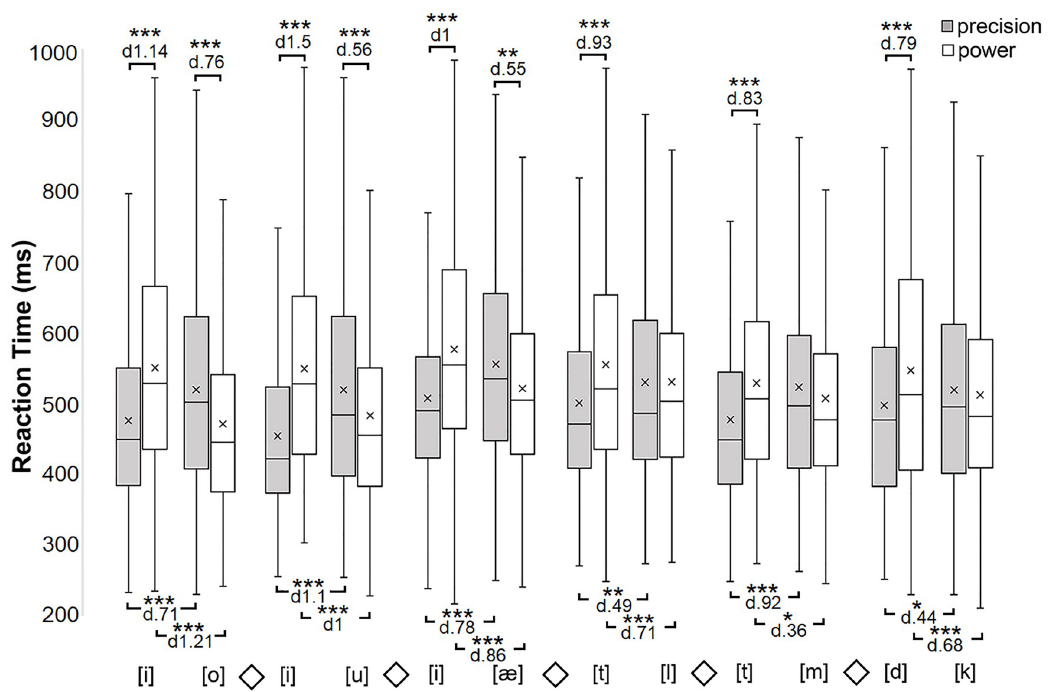
Fig 1. Box-plot of reaction times (ms = millisecond) for Experiment 1 (horizontal line inside the box = median; cross inside the box = mean; box = 25–75%; whiskers = scores outside the middle 50%). The box-plots show the distributions of RT (reaction time) values as a function of Block, Speech unit and Grip. Asterisks indicate statistically significant differences ( ��� p < .001, �� p < .01, � p <